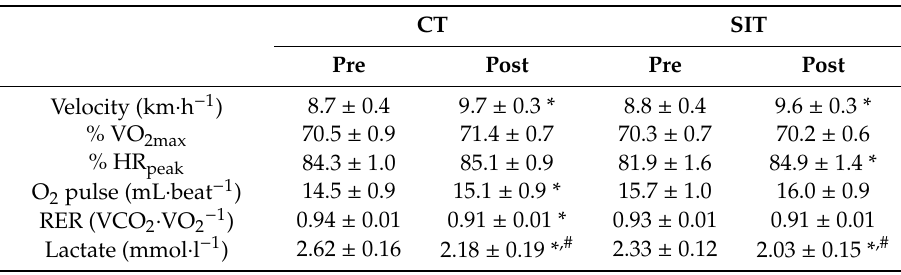
Table 4. Physiological responses to running at the velocity closest to 70 percent of maximal oxygen consumption, before (pre) and after (post) eight weeks of either continuous training (CT) or sprint interval training (SIT). CT SIT Pre Post Pre Post Velocity (km · h − 1